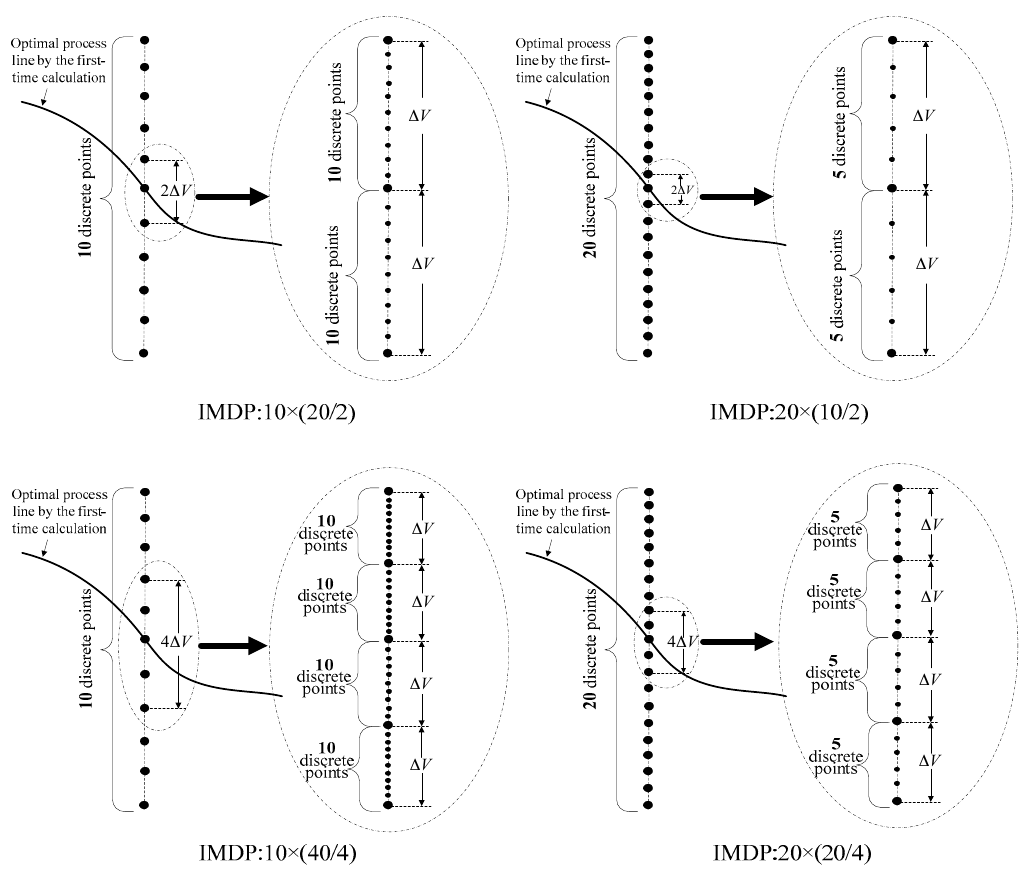
Figure 4. The construction of four schemes of IMDP with an equivalent discrete degree of 100 points in MDP .